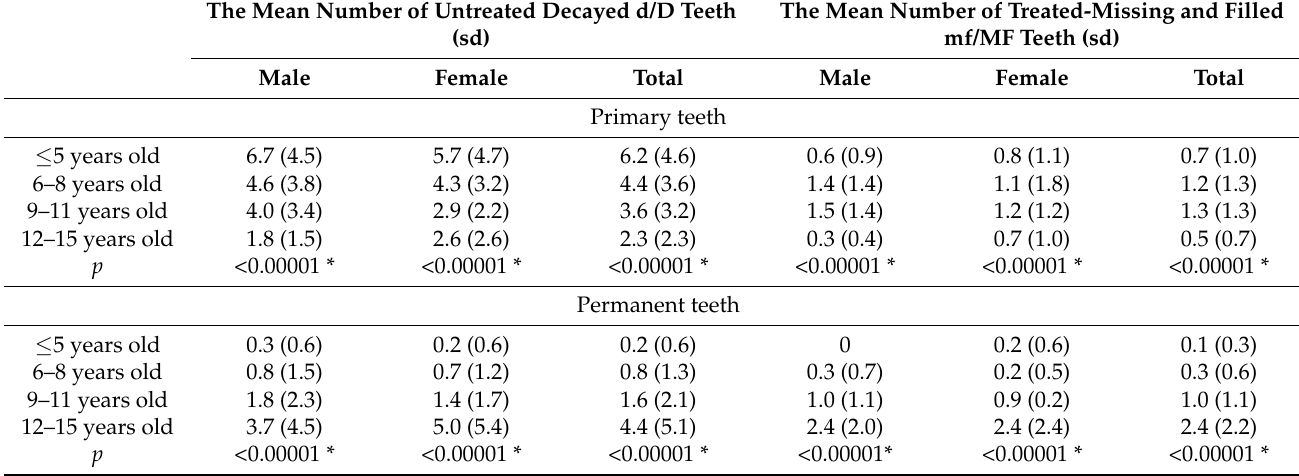
Table 3. Distribution of mean dt/DT and mft/MFT among different study groups.